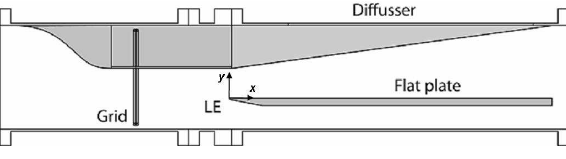
Fig. 3 . Experimental setup - flat plate with diffusser along the model of flat plate in the windtunnel test section.